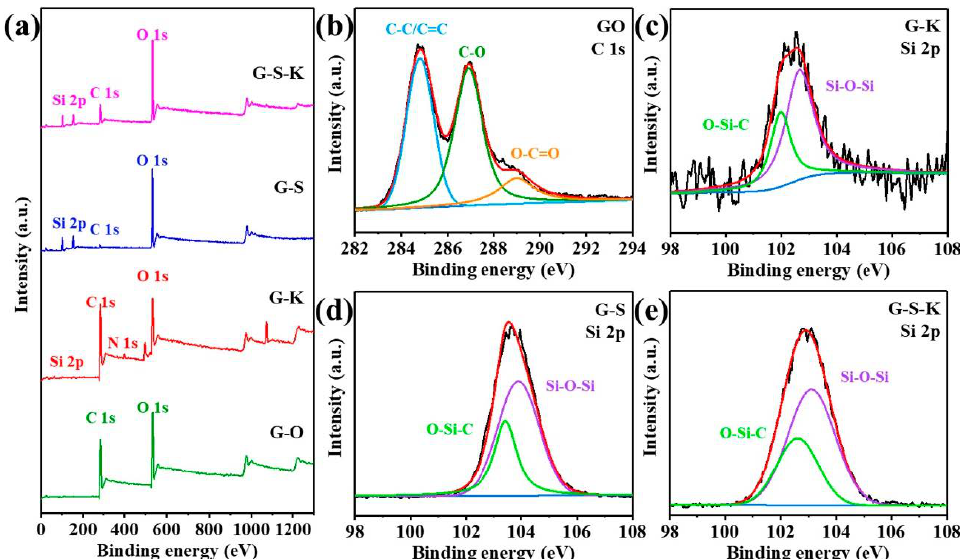
Figure 4. ( a ) XPS survey spectra and high-resolution XPS spectra of ( b ) C 1s signal for GO and Si 2p signal for ( c ) G-K, ( d ) G-S, and ( e ) G-S-K.